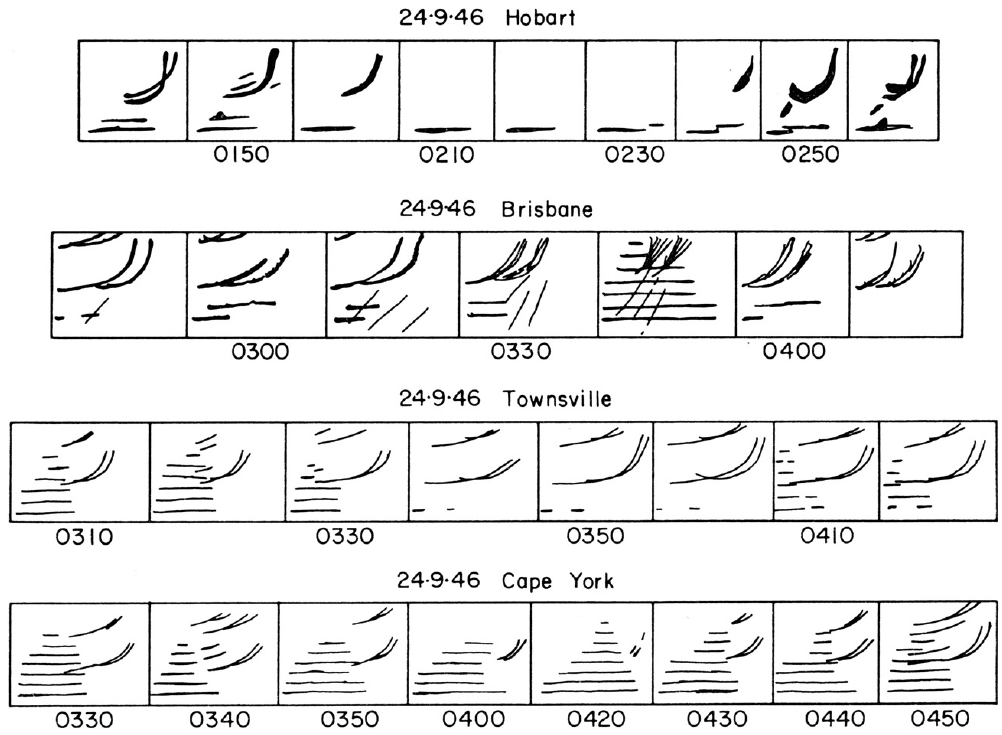
Fig. 7. A reproduction of Fig. 11 of Bowman (1965) illustrating return of the LS-TID shown by Fig. 6. The date is 24 September 1946 and involves an encirclement of the earth. The speed is 382ms − 1 .